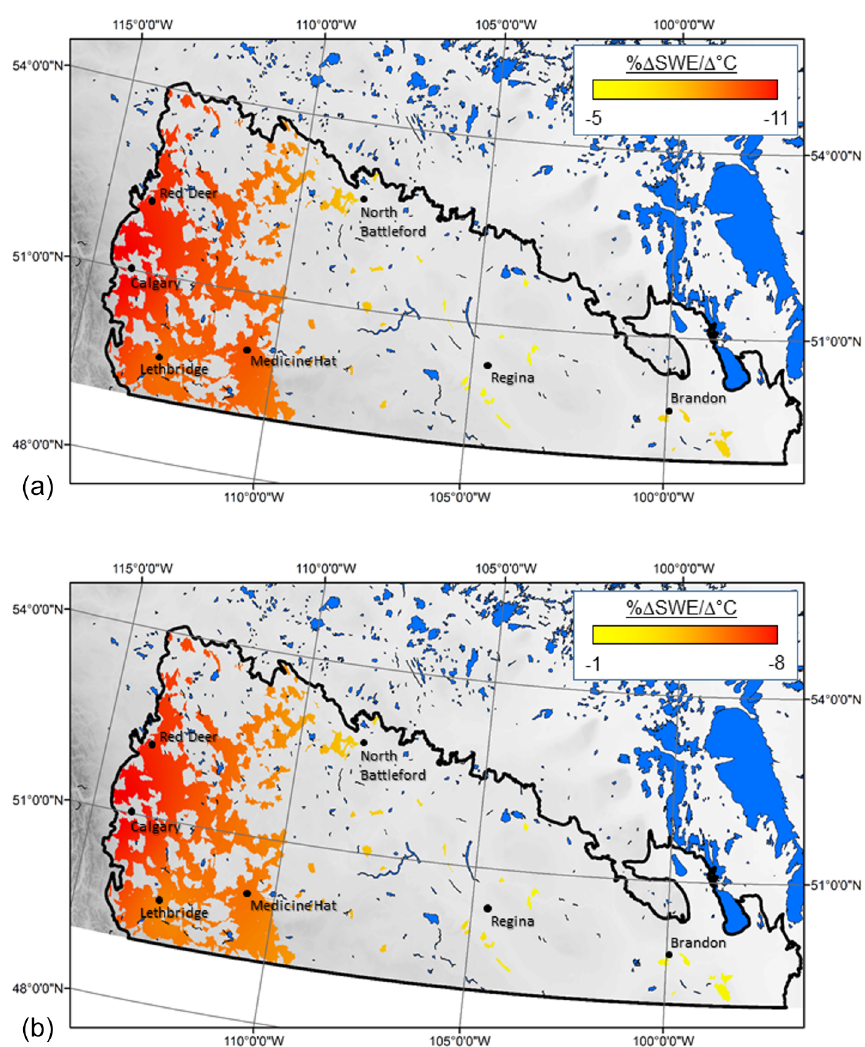
Figure 9. Sensitivity of annual maximum snow water equivalent (SWE) in the grassland HRU to warming, assuming no change in precipi- tation (a) , and a 30% increase in mean annual precipitation (b)